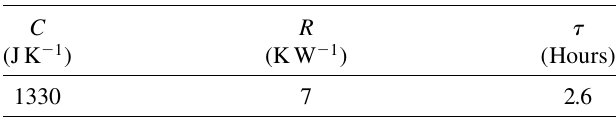
TABLE II. Measured thermal capacitance, C , thermal resis- tance, R , and time constant (cid:11) .